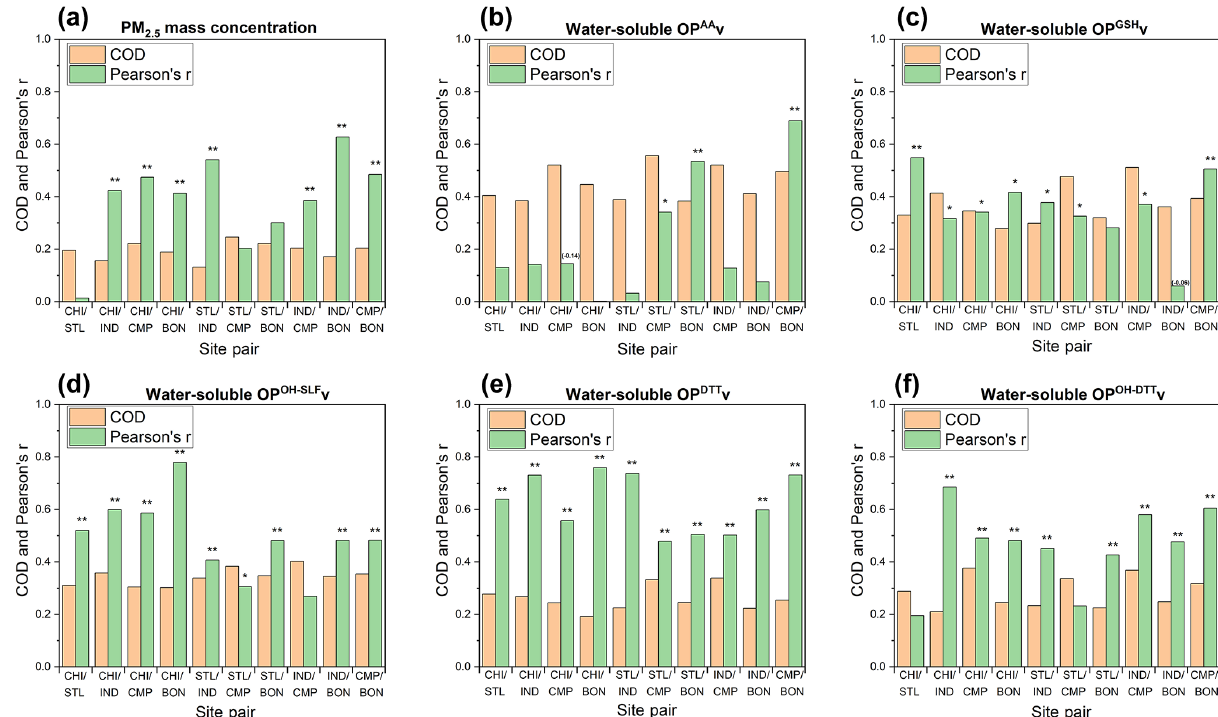
Figure 8. Coefficient of divergence (CoD) and Pearson’s r for site-to-site comparison of (a) PM 2 . 5 mass and water-soluble OP activities: (b) OP AA v, (c) OP GSH v, (d) OP OH − SLF v, (e) OP DTT v, and (f) OP OH − DTT v. Single asterisks ∗ and double asterisks ∗∗ on the bars of Pearson’s r indicate significant ( P < 0 . 05) and very significant ( P < 0 . 01) correlations, respectively. Note: r values for the correlations of OP AA v between CHI and CMP and for the correlations of OP GSH v between IND and BON were negative ( − 0 . 14 and − 0 . 06,